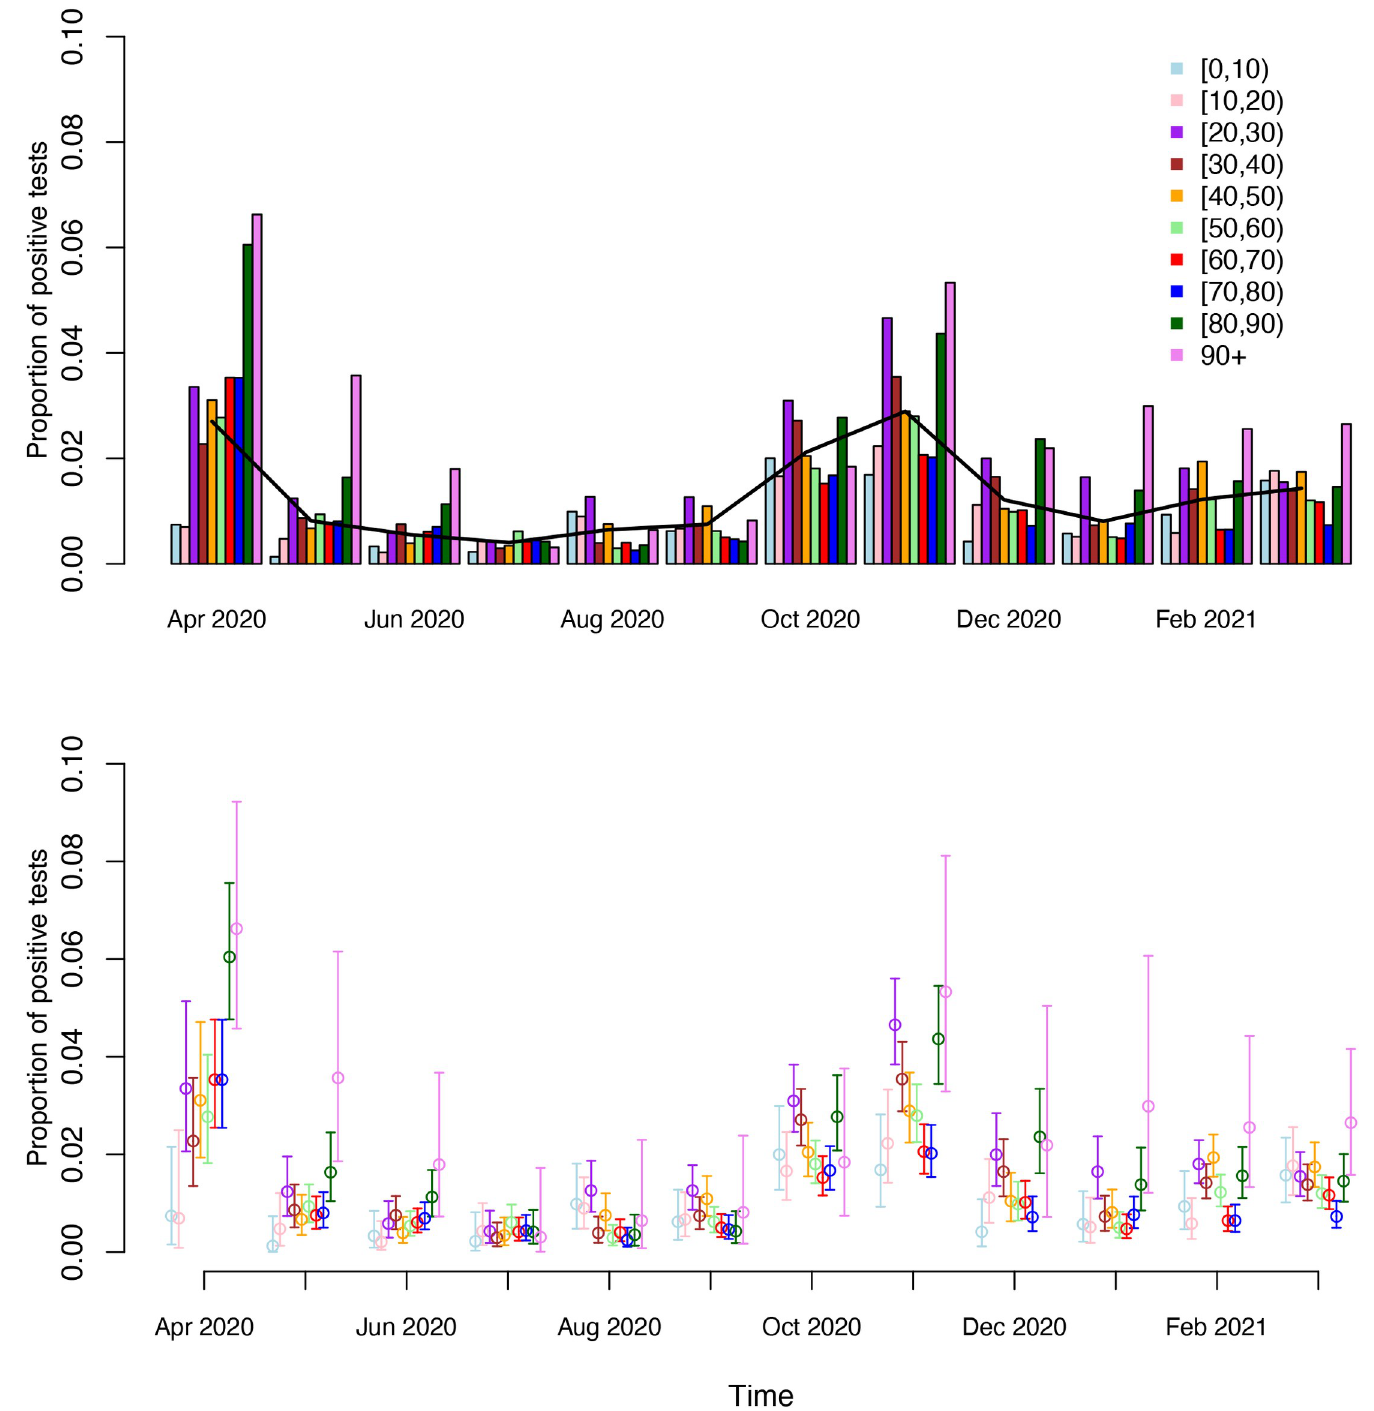
Fig 2. Evolution of the monthly SARS-CoV-2 real-time RT-PCR positivity ratio in a-/pre-symptomatic patients screened pre-hospitalization/pre-surgery by ten- year age group as a function of time (from 1 April 2020 to 31 March 2021). The black solid line shows the age-weighted overall SARS-CoV-2 positivity ratio based on the age distribution in Belgium anno 2020. Error bars represent 95% exact Clopper-Pearson confidence limits for the age-specific positivity ratios.